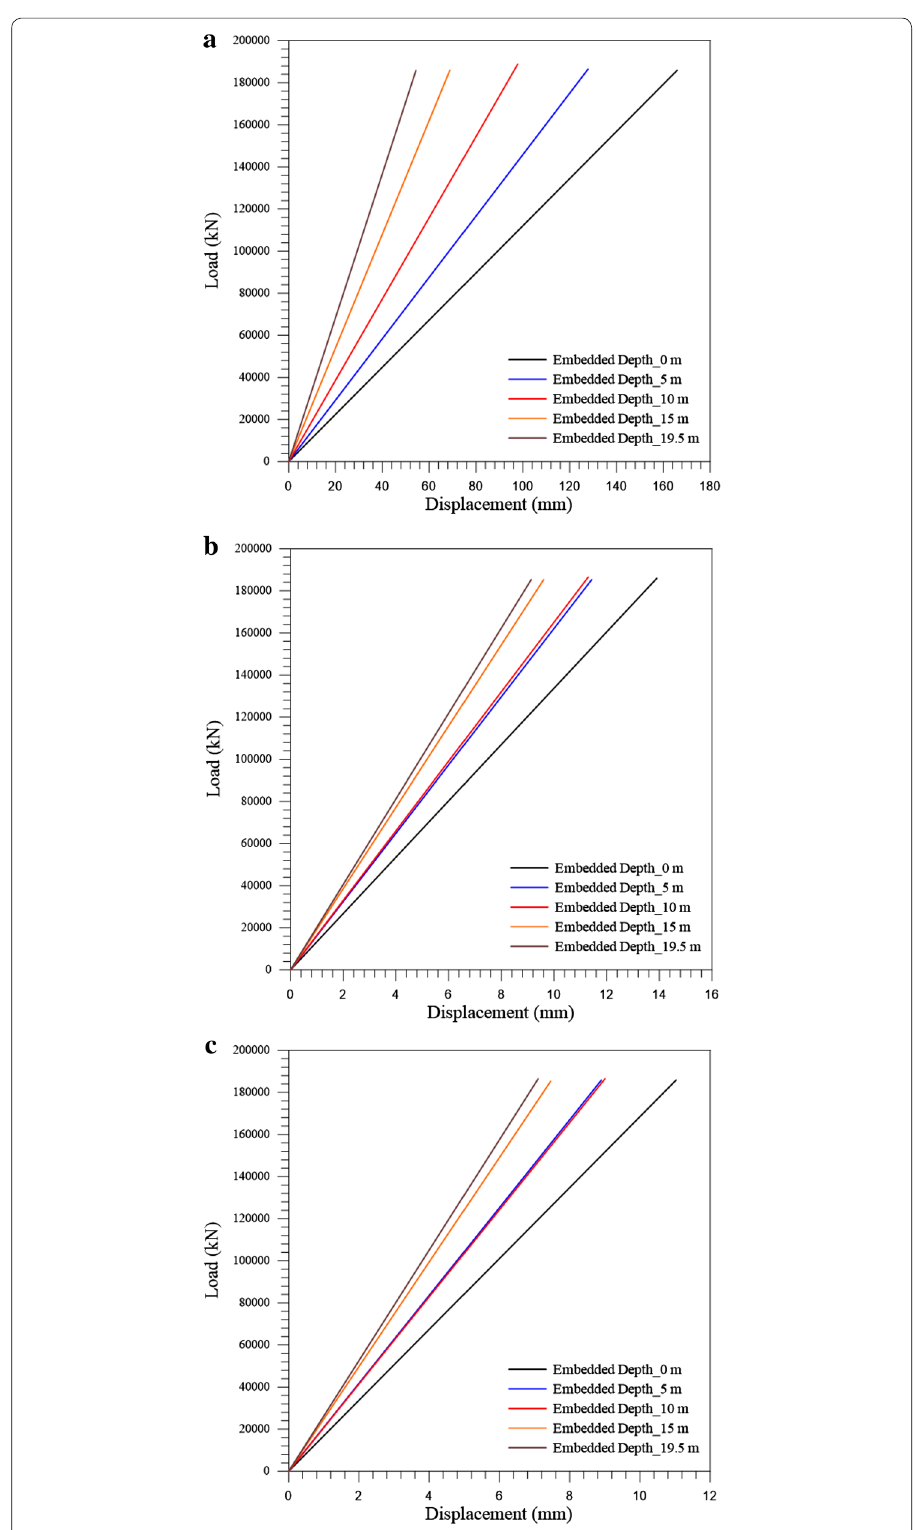
Fig. 3 Load-displacement curves with the embedded depth: a weathered rock; b soft rock; and c hard